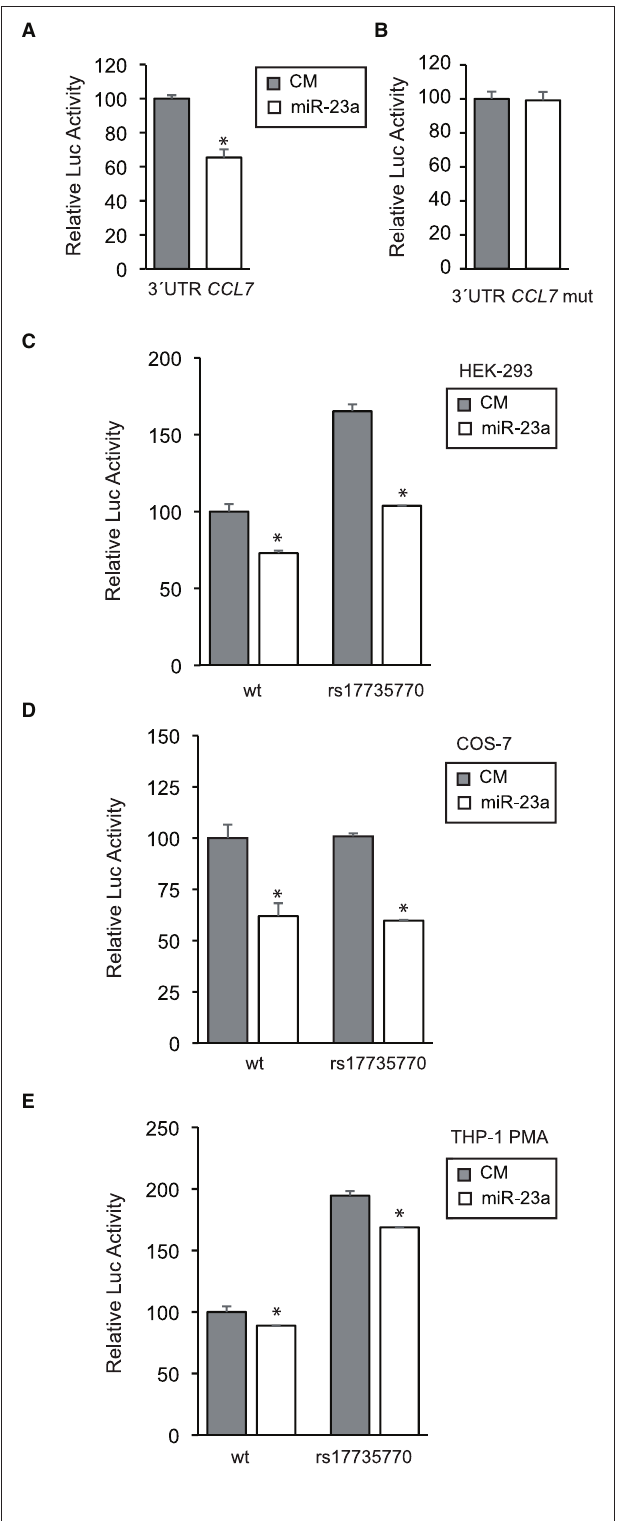
FIGURE 2 | Functional evaluation of the miR-23 binding site at the human CCL7 3’UTR. (A) The human CCL7 gene 3’UTR was cloned downstream of a Renilla luciferase reporter and transfected into HEK-293 cells along with a